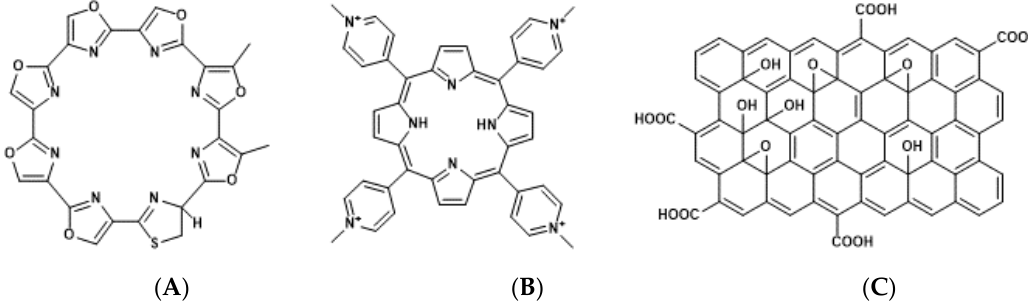
Figure 3. Chemical structures of telomestatin ( A ), tetra-meso (N-methyl-4-pyridyl) (TMPyP4) ( B ), and graphene oxide (GO) complex (TMPyP@GO) ( C ).